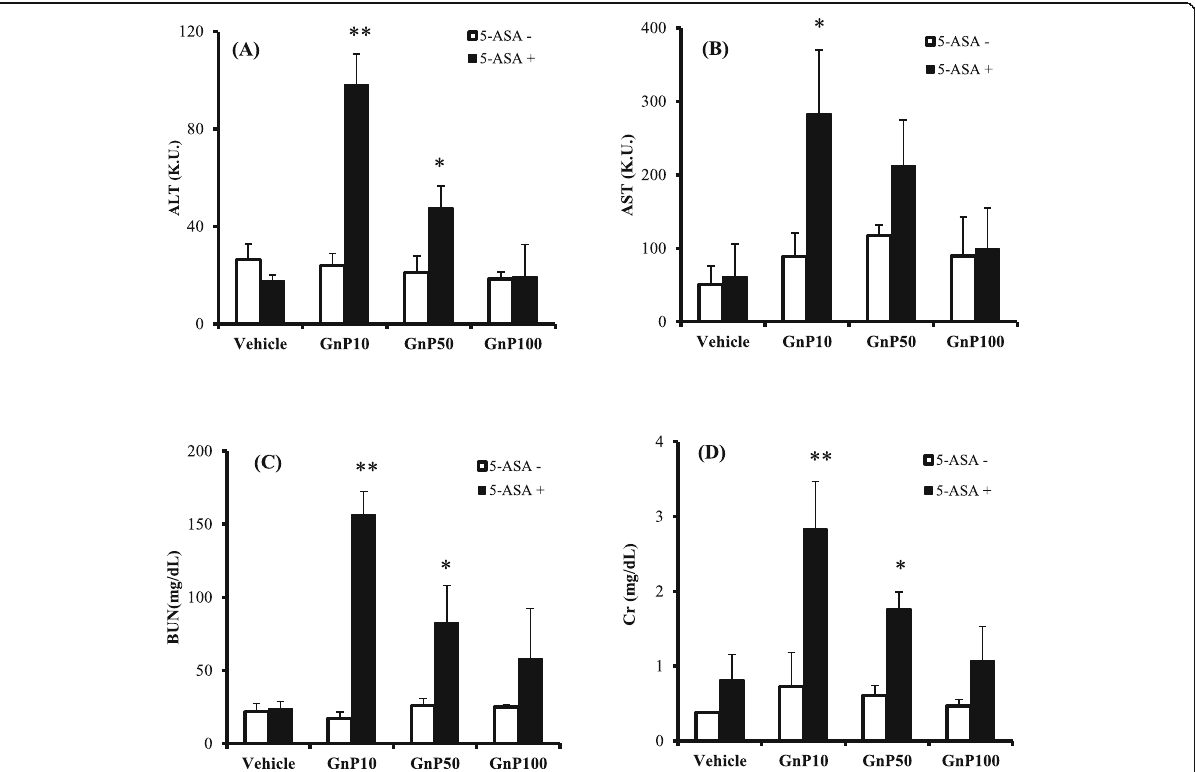
Fig. 3 Effect of gold nanoparticles on 5-aminosalicylic acid-induced toxicity. Mice were injected intraperitoneally with 5-aminosalicylic acid (5- ASA) at 0 (open bars) or 500 mg/kg (solid bars), together with an IV injection of vehicle or gold nanoparticles (4 mg/kg). At 24-h post-injection, serum levels of the liver enzymes alanine aminotransferase (ALT; a ) and aspartate aminotransferase (AST; B), and plasma levels of blood urea nitrogen (BUN; c ) and creatinine (Cr; d ) were determined using commercially available kits (see “ Biochemical analyses ” section). Data are presented as mean ± standard error of the mean (SEM; n = 4). Significant difference (* P < 0.05, ** P < 0.01) between vehicle- and 5-ASA-treated